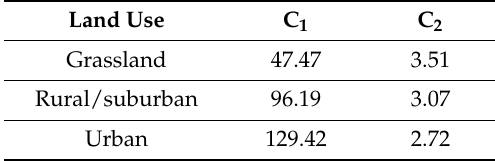
Table A2. Pipe unit cost coefficients.